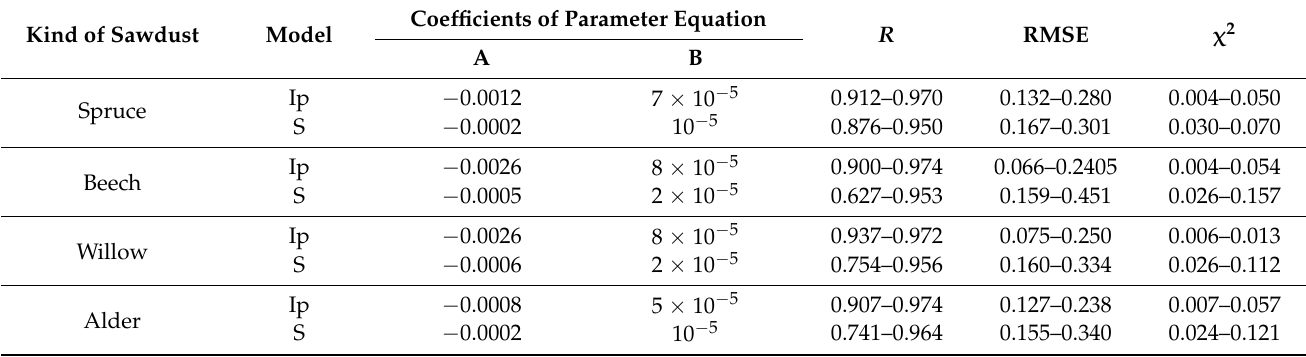
Table 4. Coefficients of parameter equation ( D / L 2 ) for theoretical models of sawdust drying, and comparison of results of statistical analyses on the modelling of spruce, beech, willow, and alder. Kind of